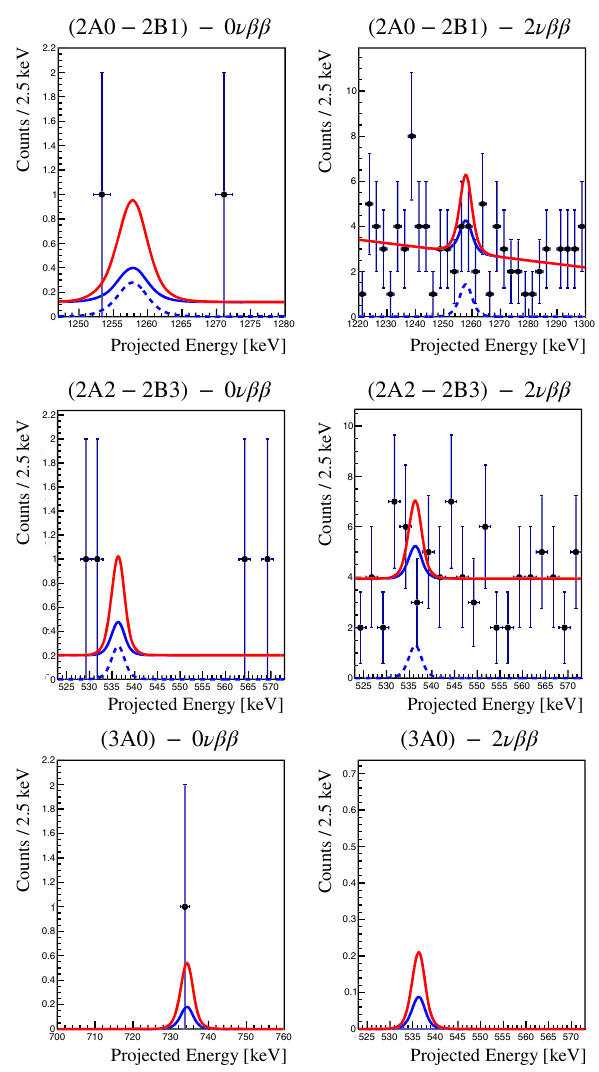
Fig. 3 Result of the unbinned fit plotted on binned data. Error bars are justavisualaidandcorrespondtothesquarerootofthebincontents.We show the best fit curve (blue solid), its signal component (blue dashed) at the global mode of the posterior for 0 νββ (left) and 2 νββ (right), and the 90% C.I. marginalized limit on the decay rate (red solid)